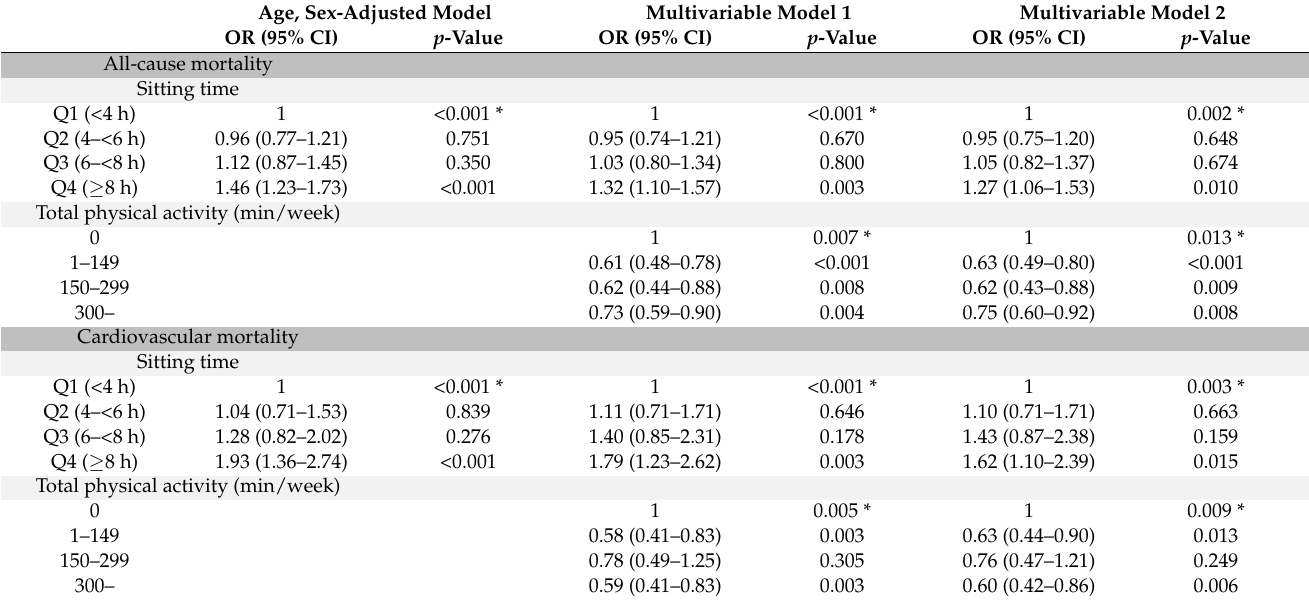
Table 6. Multivariable Hazard Ratio for All-Cause and Cardiovascular Mortality based on the Amount of Sitting Time among Individuals with NAFLD as defined by the Hepatic Steatosis